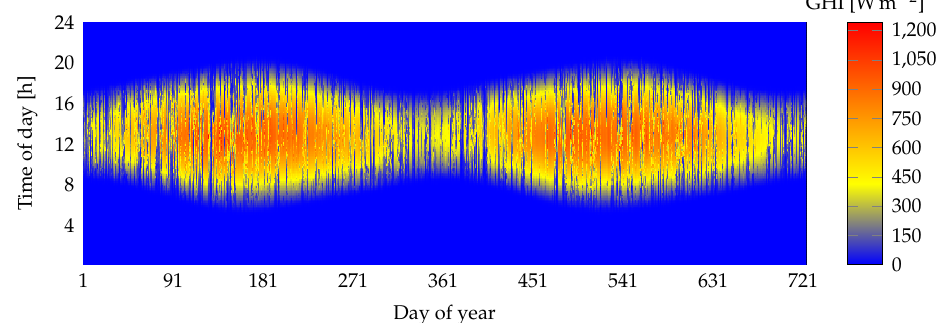
Figure 7. GHI data covering years 2016 and 2017. Measurements are taken with a rotating shadow- band irradiometer at PROMES-CNRS laboratory, located in Perpignan (southern